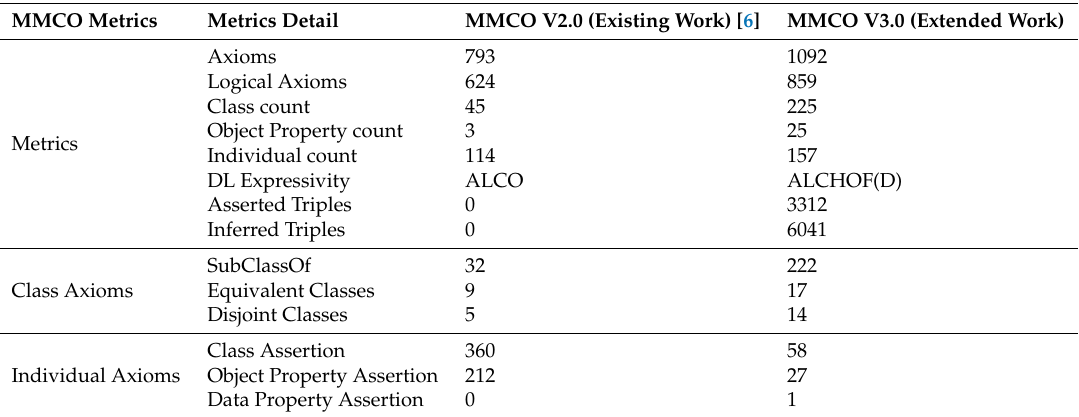
Table 1. Ontology Metrics during Ontology